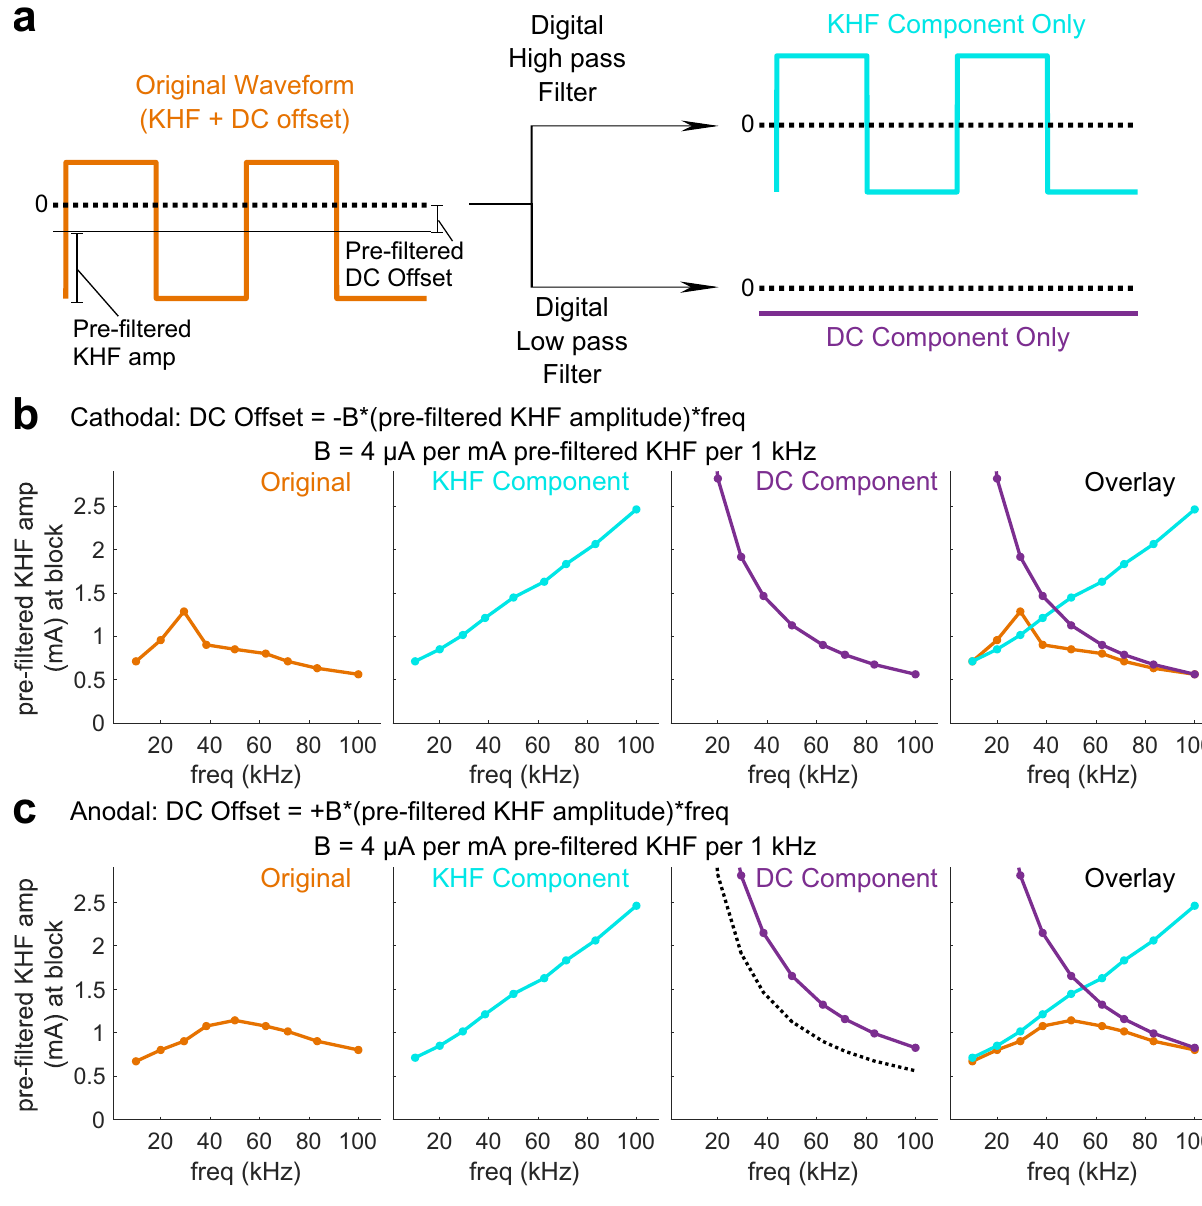
Figure 6. Computational models of block thresholds across frequencies for KHF and DC offset components separately in a 5.7 μm diameter fiber. ( a ) Original waveforms consisted of KHF symmetric rectangular waves with added DC offset that scaled with KHF amplitude and frequency. Digital high pass or low pass filters preserved only the KHF or DC components of the original signal, respectively. DC offsets were either cathodal ( b ) or anodal ( c ) at ± 4 μA DC per mA pre-filtered KHF amplitude per 1 kHz. ( b , c ) KHF amplitude of Original waveforms (y-axis) required for block with Original waveforms (orange), KHF component only (cyan), or DC component only (purple). Threshold curves for Original waveforms in ( b , c ) were identical to the corresponding ± 4 μA DC per mA KHF amplitude per 1 kHz curves in Fig. 3e,f. Threshold curves for KHF components in ( b , c ) were identical to the zero DC offset curves in all panels of Fig. 3. The black dotted line in the ‘DC Component’ panel of ( c ) shows the threshold curve from the cathodal DC component ( b ) for